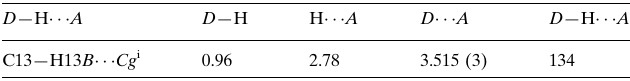
Hydrogen-bond geometry (A˚ , (cid:2) ). D —H (cid:1)(cid:1)(cid:1) A